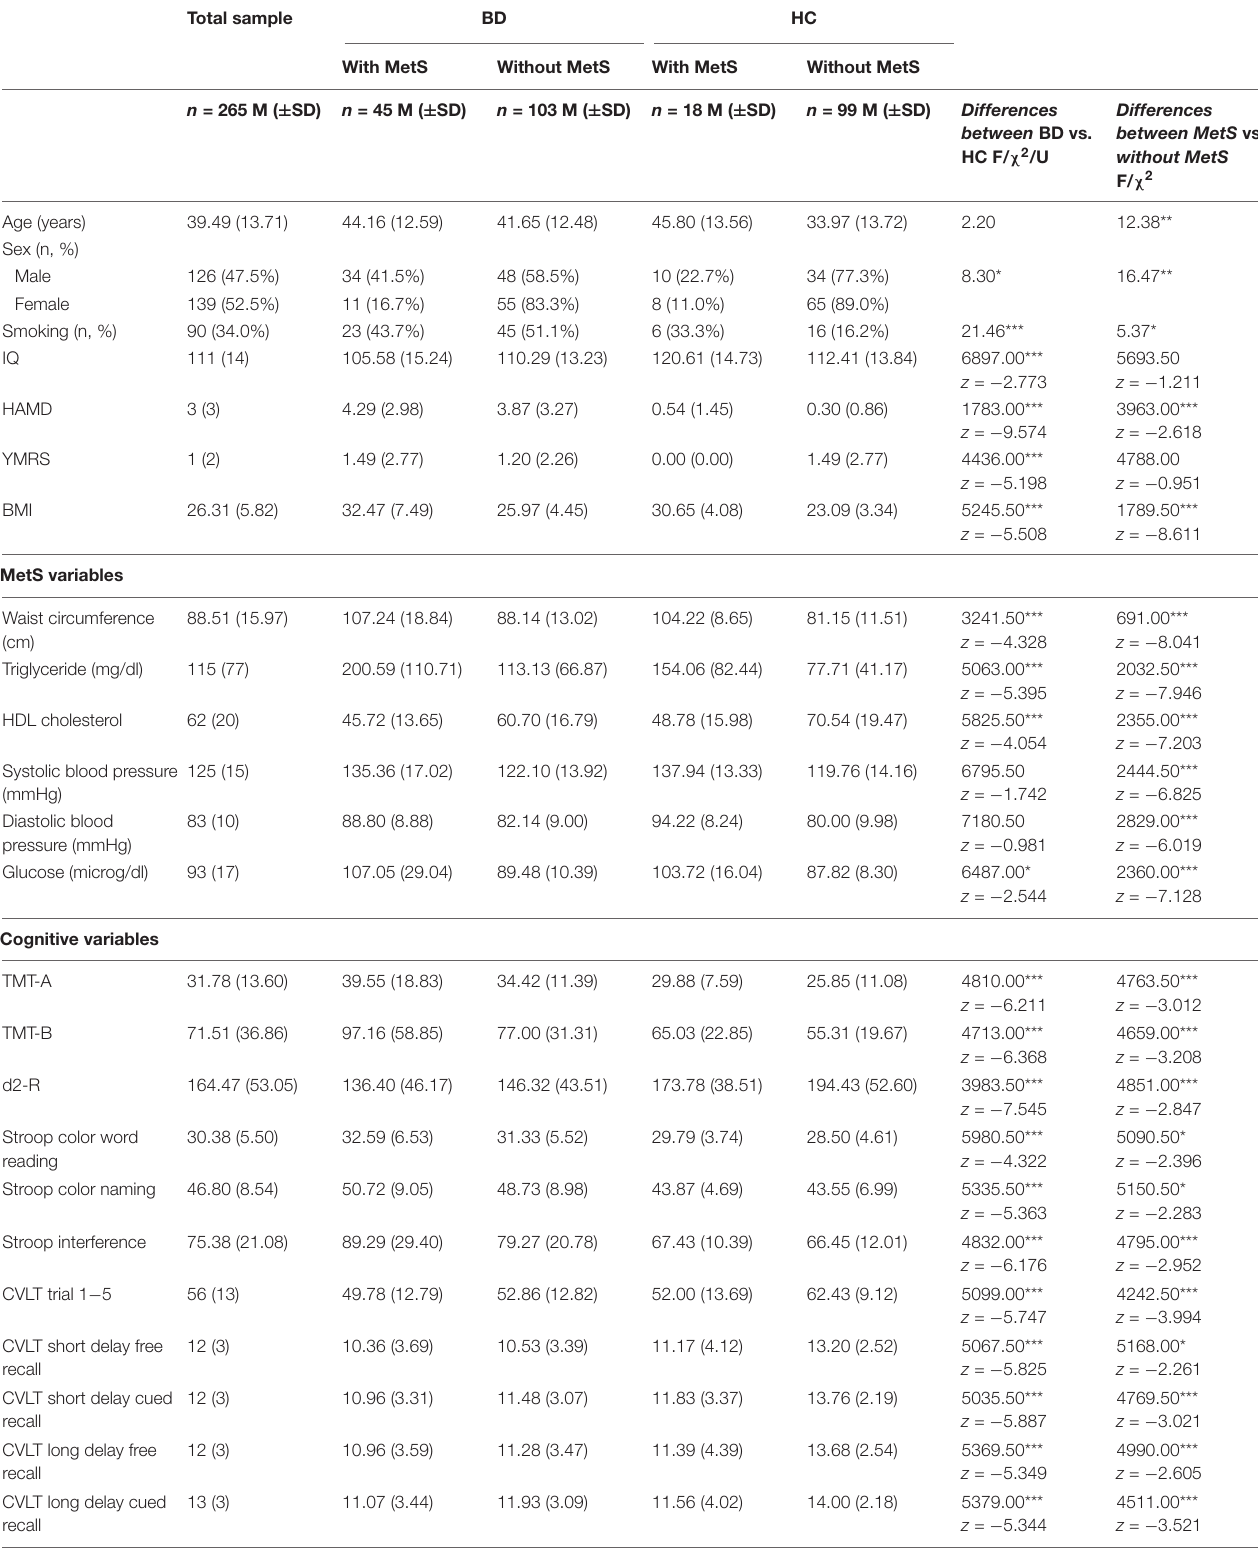
TABLE 1 | Baseline demographic and clinical variables for participants in the total sample (BD vs. HC) and by MetS